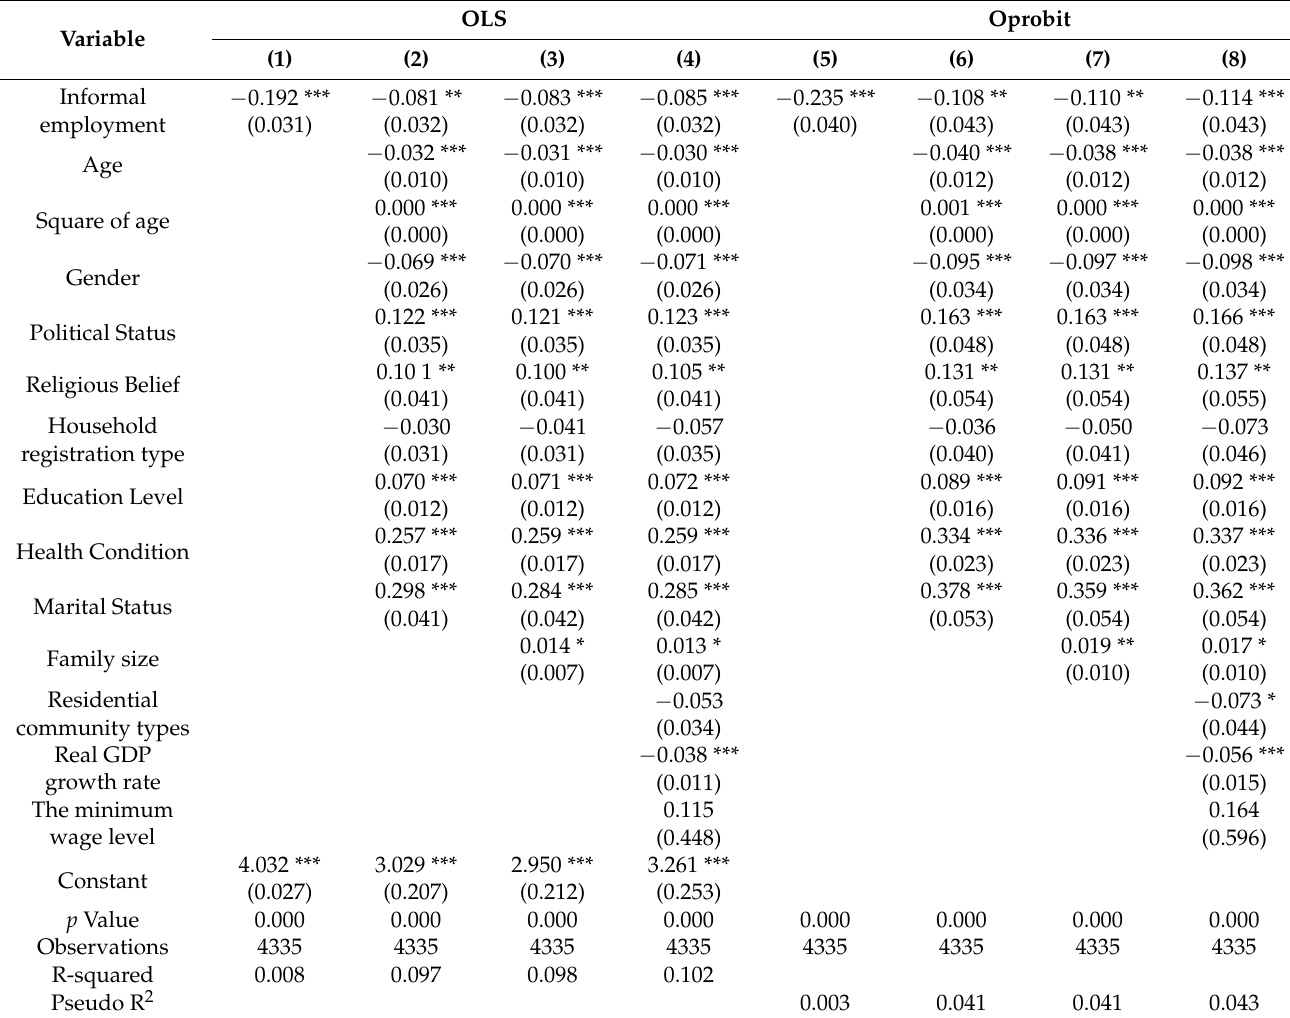
Table 2. Informal employment and residents’